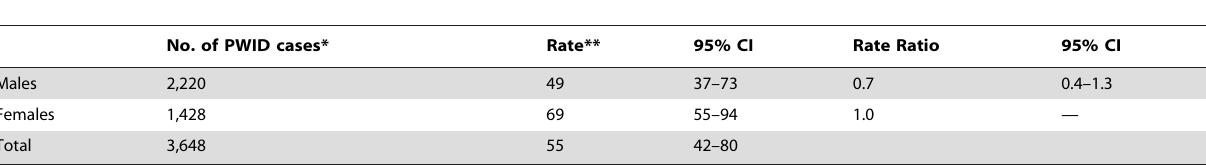
Table 5. Diagnoses of HIV infection among persons who inject drugs (PWID), by sex- - United States, 2011.